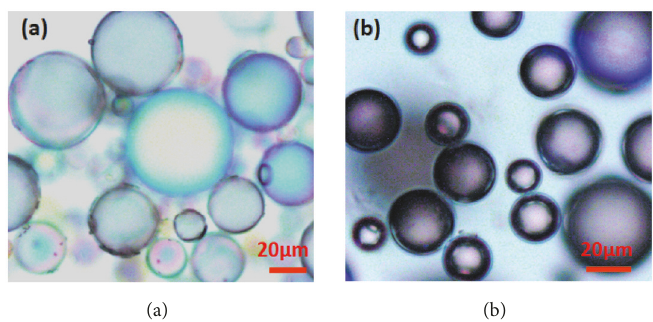
Figure 10: Optical images of the char obtained after oxidative degradation of (a) SF15-60 and (b) SF46-60.